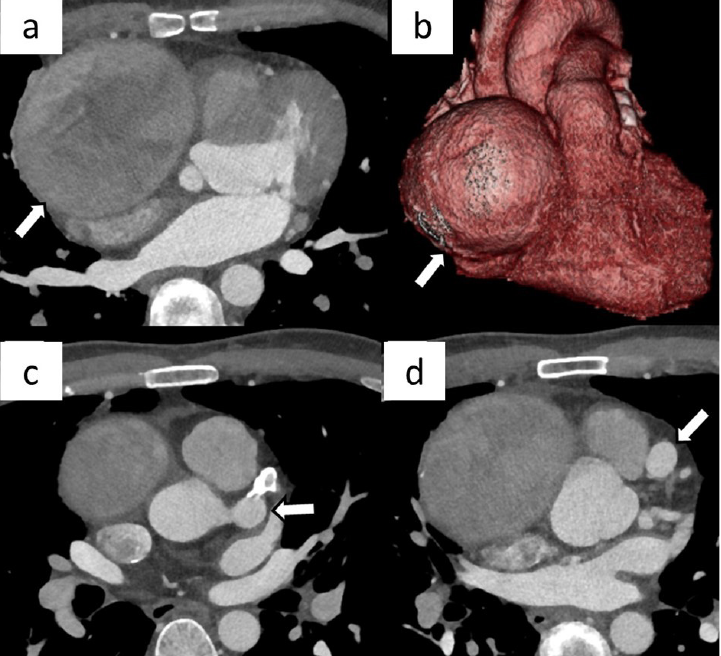
Fig. 1 - Preoperative cardiac computed tomography scan findings. a, b) Super-giant right coronary artery aneurysm (CAA) (88 mm) arising from the aortic root and displacing the right atrium (arrow). c) Giant CAA (14 mm) in the left main trunk (arrow). d) Giant CAA (12 mm) in the left anterior descending artery (arrow).